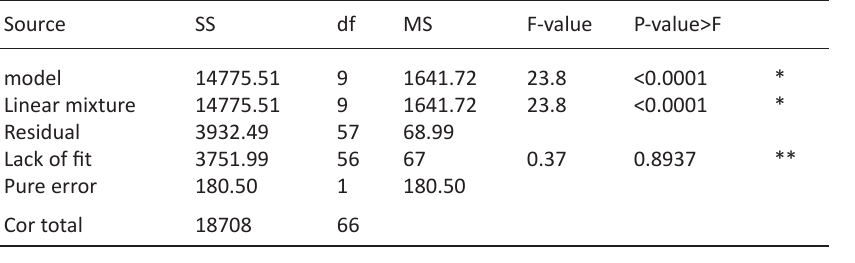
Table 3. Analysis of variance (ANOVA) for actinorhodin production by Streptomyces coelicolor A(3)2 Source SS df model Linear mixture Residual Lack of fit Pure